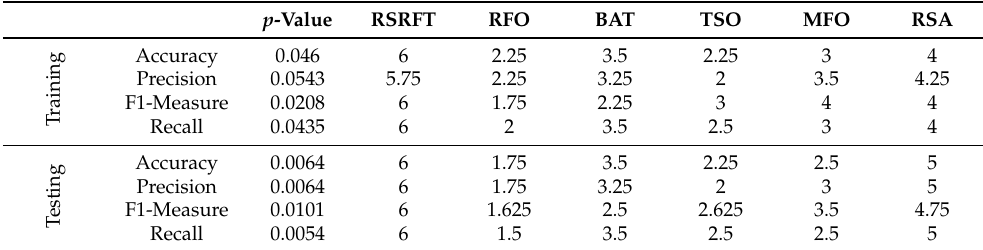
Figure 9. Performance measures of RSRFT using the testing set. Table 9. The mean rank using the Friedman